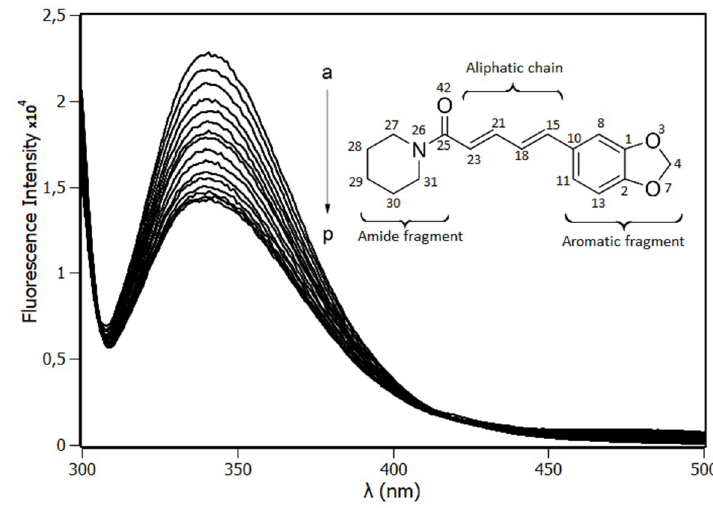
Figure 1. Rat serum albumin (RSA) emission spectra from 305 to 500 nm [RSA] = 4.0 µM. Piperine concentration from 0 to 15 µM (a  p) with increments of 1 µM (pH 7.4, T = 288 K, λ exc =295 nm). The insert is the molecular structure of piperine.